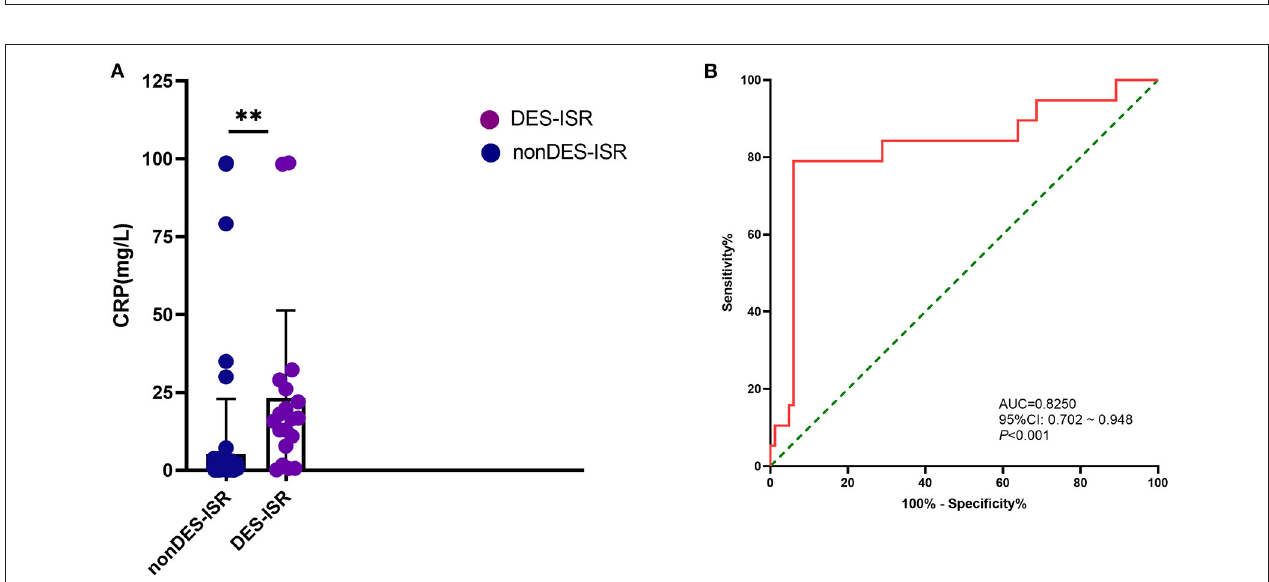
FIGURE 3 | sub-grouped by dyslipidemia. (E) The rate of DES-ISR in patients with different HbA1c-CV levels as sub-grouped by gender. (F) The rate of DES-ISR in patients with different HbA1c-CV levels as sub-grouped by age. (G) The rate of DES-ISR in patients with different BMI as sub-grouped by HbA1c levels. (H) The rate of DES-ISR in patients with different CRP levels as sub-grouped by HbA1c-CV. (I) ROC curve and its predictive performance of HbA1c-CV. (J) ROC curve and the predictive performance of FPG-CV, HbA1c-M, HbA1c-SD, FPG-M, FPG-SD and HbA1c-CV. * P < 0.05, ** P < 0.01 comparison among T1-T4 groups; # P < 0.05 comparison between subgroups; ns = not significant.